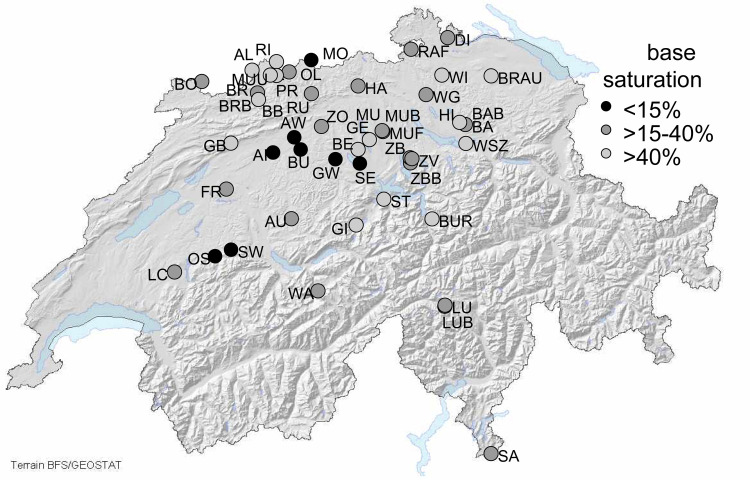
Forest plots with soil solution samplers (sampled in 2017 and 2018), grouped according to the base saturation of the topsoil (average 0–40 cm).